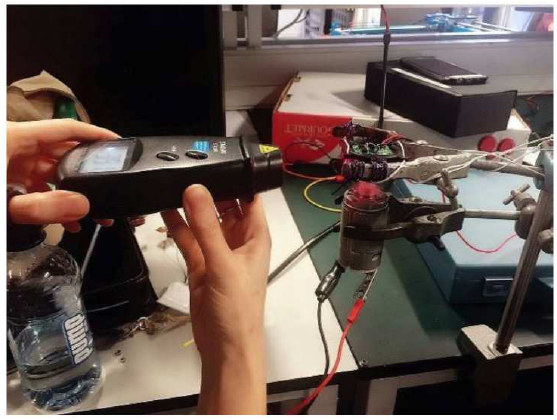
Figure 11. Tacho meter measuring RPM of a turbine spun by a DC motor.